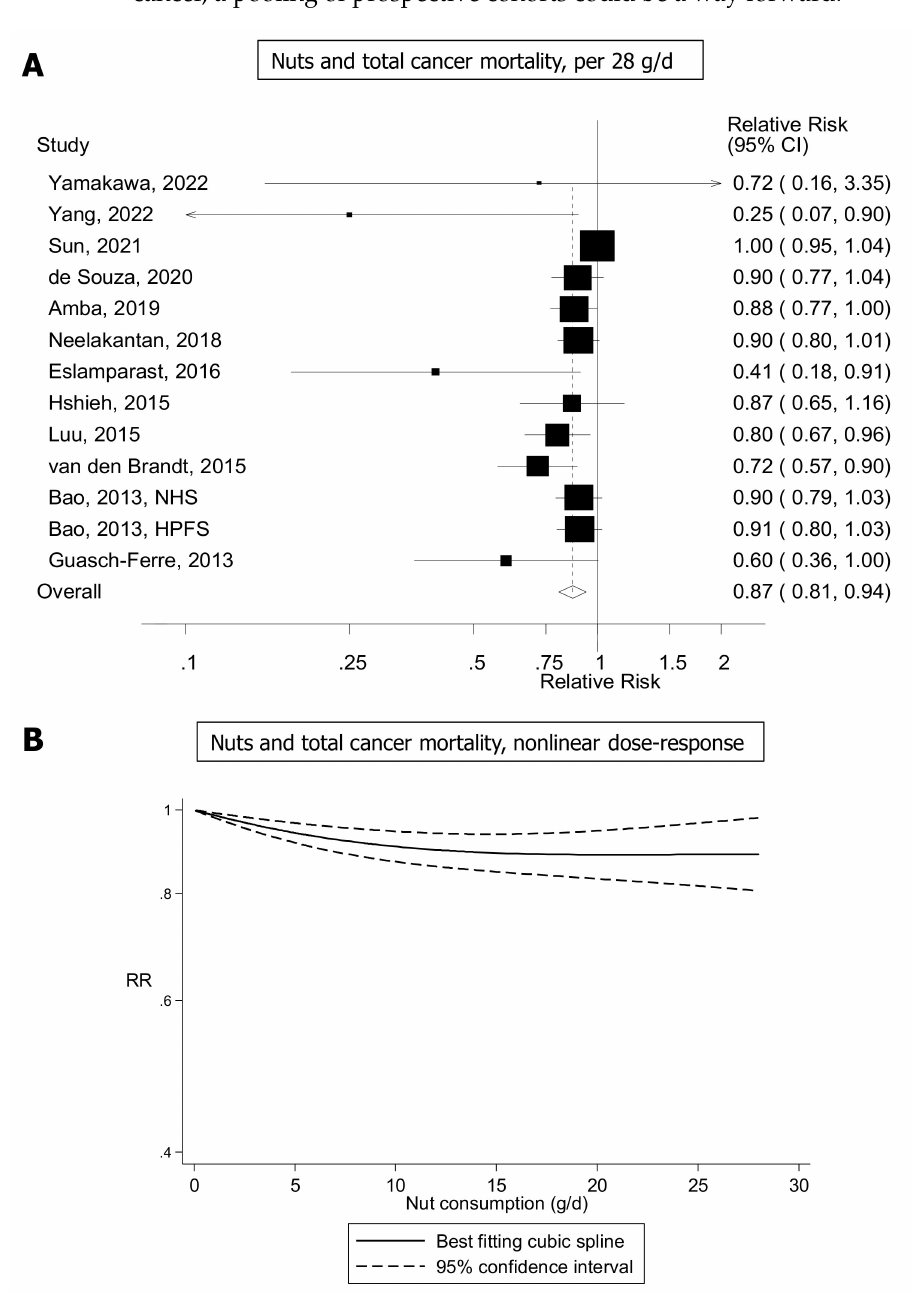
Figure 1. Nuts and total cancer mortality, linear ( A ), and nonlinear ( B ) dose-response analysis (updated analysis based on Aune et al.)